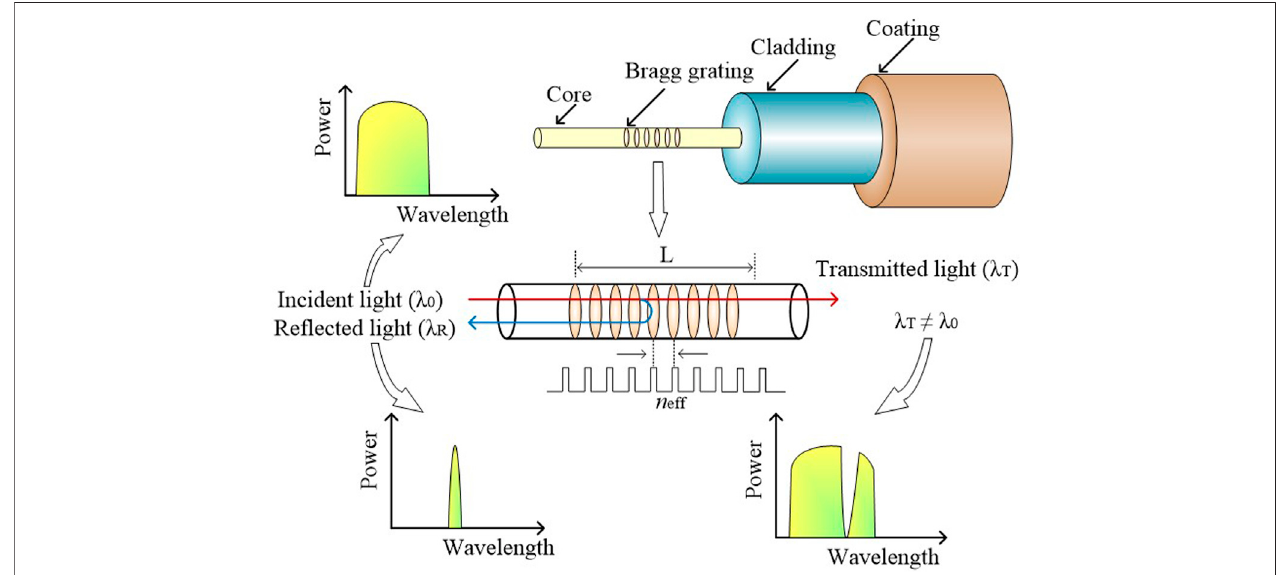
FIGURE 1 | Working principle of FBG sensing technology.